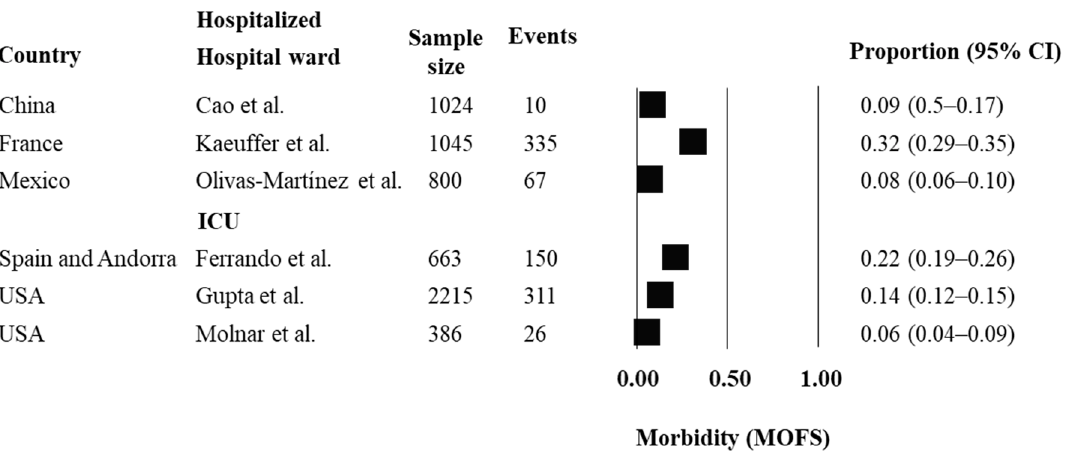
Figure 4. Prognosis of morbidity, considering MOFS, in hospitalized people with COVID-19. For analysis, the studies were grouped by country and by hospital setting (hospital ward or ICU). Esti- mates of proportions for dichotomous data, considering the number of events and sample size, were reported. Abbreviations: MOFS = multiorgan failure syndrome; USA = United States of America; IC = confidence interval. References: Cao et al. [15]; Kaeuffer et al. [19]; Olivas-Martínez et al. [23]; Ferrando et al. [39]; Gupta et al. [41]; Molnar et al. [42]. People hospitalized in hospital wards showed better prognosis; i.e., higher propor- tion of recovery (discharge to home), with estimates ranging from 55% to 94%. In ICU, recovery rates ranged from 22% to 76%; with higher recovery rates in Italy (55%), Spain (65%) and UK (76%). See Figure 5 for further details.